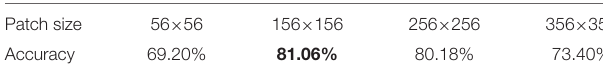
TABLE 1 | The parameters of network training. TABLE 2 | The accuracy of material classification vs. patch